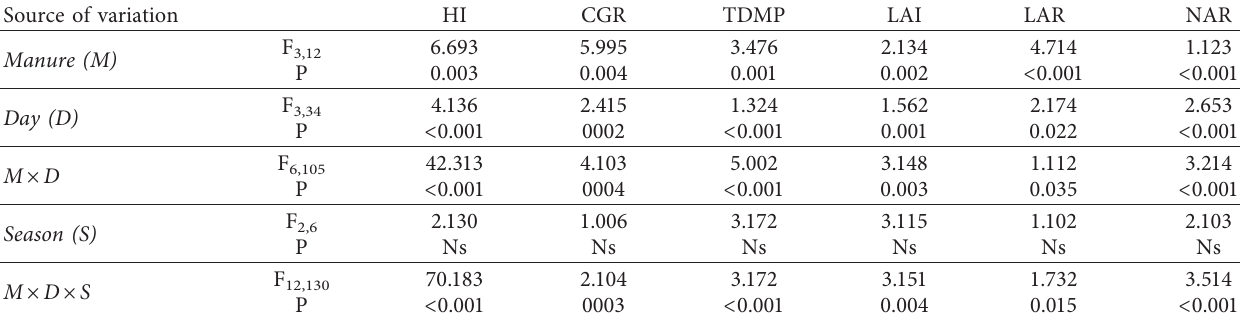
Table 3: The ANOVA summary for the mean square values of the baby spinach growth parameters and yield during the three years. Source of variation HI CGR TDMP LAI LAR NAR F Manure (M)